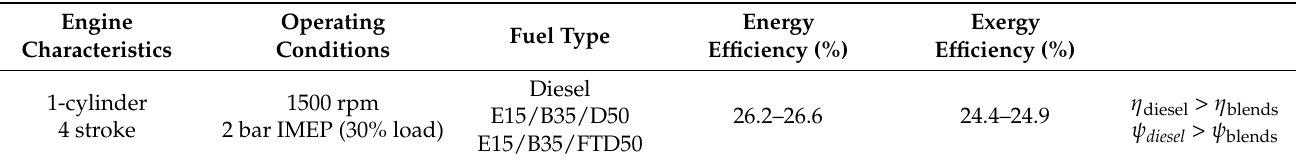
Table 6. Summary of the energy and exergy results of this work.